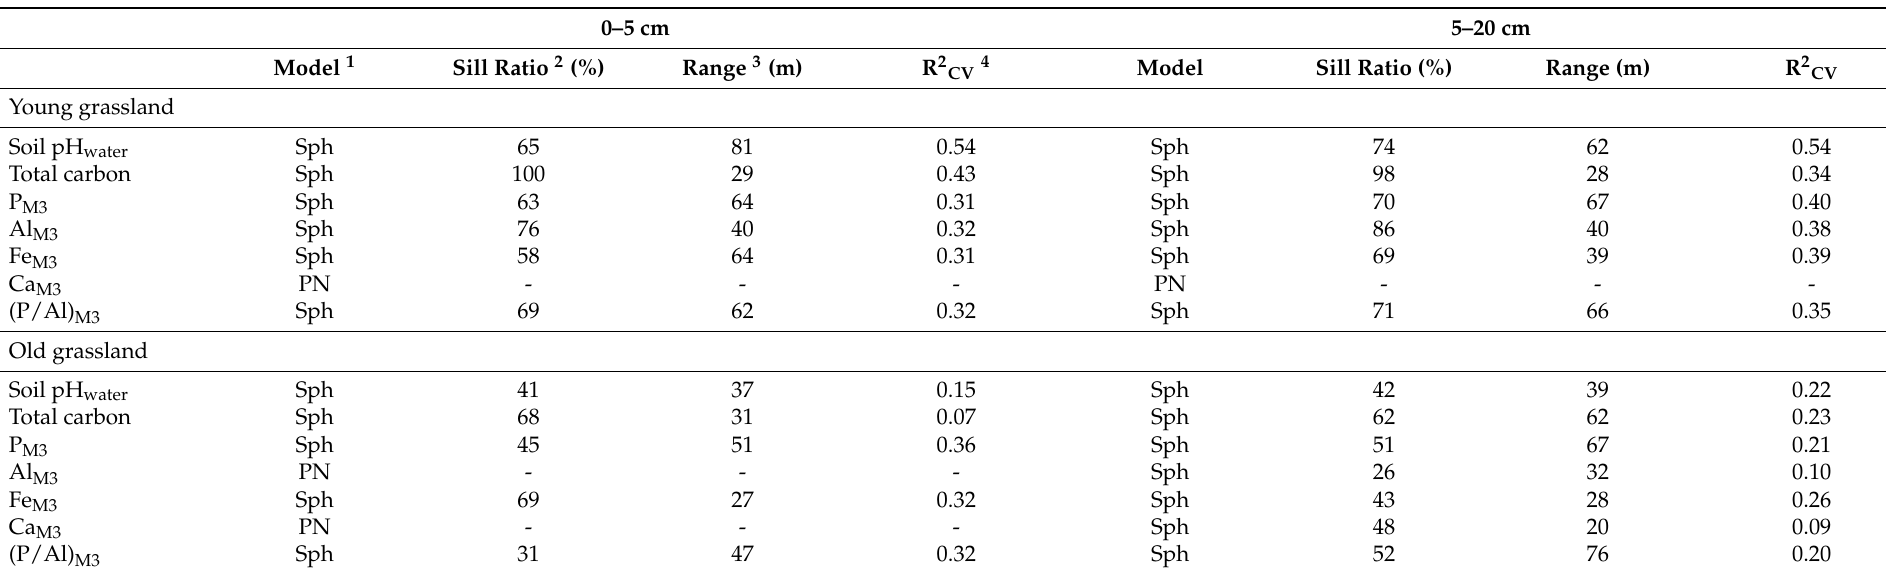
Table 2. Geostatistical parameters of the soil chemical properties for two soil layers (0–5 cm) and (5–20 cm) from the young and old grassland